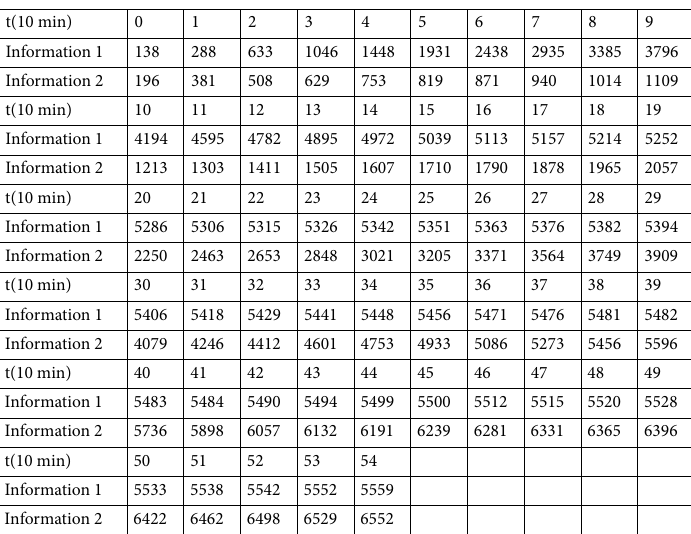
Table 2. Two cumulative forwarding number of public hot event 1-“A girl was killed by a taxi (DiDi in China) driver”, Aug.25th, 2018, a 20-year-old girl was raped and killed by a taxi driver in Yueqing, Zhejiang province. At 11:23 a.m., information 1 about the girl had asked a friend for help before she was killed appeared at a lower exposure, nearly at the same time, information 2 about the murderer had been caught burst at a relatively high exposure, and both information was posted by @ Toutiaonews